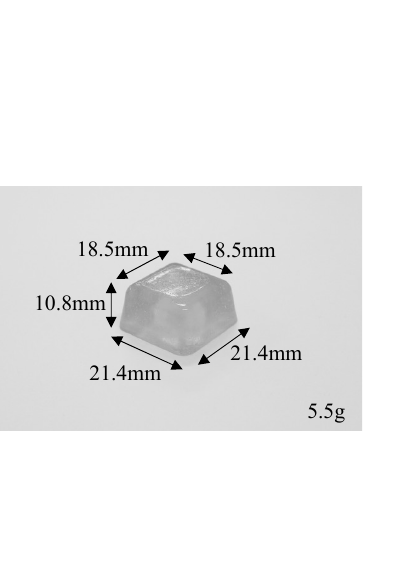
Figure 1. Evaluation of masticatory performance with full-size test gummy jelly. ( A ) A sample of the full-size test gummy jelly. ( B ) The visual scoring table of full-size test gummy jelly. Only patients with the visual score of 4 or less were included in this study.